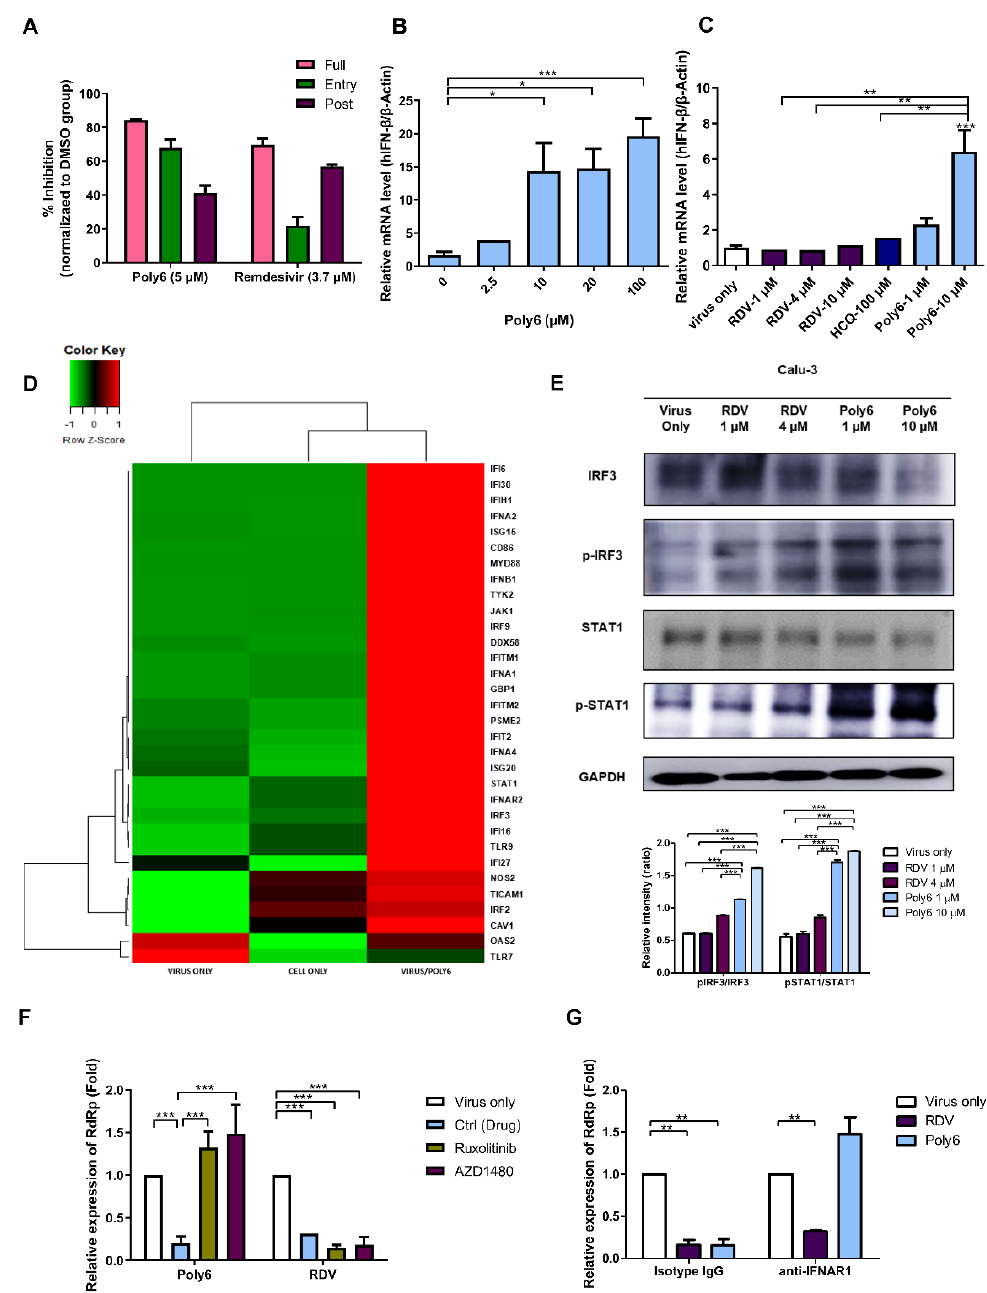
Figure 4. Poly6 exerts an anti-SARS-CoV-2 effect in Calu-3 cells in an IFN-I-dependent manner ( A ) Time-of-addition experiment of Poly6 and RDV and three time points of administration were tested. ( B ) Calu-3 cells were treated with Poly6 in the absence of infection, and the mRNA expression level of IFN β was evaluated via RT-qPCR ( C ). Calu-3 cells were treated with RDV, HCQ, and Poly6 following infection, and the mRNA expression level of IFN β was evaluated via RT-qPCR. ( D ) mRNA expression profiles for IFN-I response genes encoding interferons/receptors in SARS-CoV-2 infected Calu-3 cells and following treatment of Poly6. A heatmap is depicted. ( E ) Western blot analysis of Calu-3 cells treated with PBS, RDV, and Poly6 following SARS-CoV-2 infection. ( F ) The IFN-I-dependent antiviral effect of Poly6 against SARS-CoV-2 was investigated with Ruxolitinib and AZD1480. ( G ) Calu-3 cells were pre-incubated with IFNAR1 and isotype IgG antibodies (10 µ g/mL) for 2 h and treated with RDV or Poly6 following SARS-CoV-2 infection. RT-qPCR measured SARS-CoV-2 RdRp expression level. Data represent the mean ± SD. * p < 0.05, ** p < 0.01, and *** p < 0.001. The experiments were performed in triplicate and repeated twice for confirmation. Abbreviation: RdRp, RNA-dependent RNA